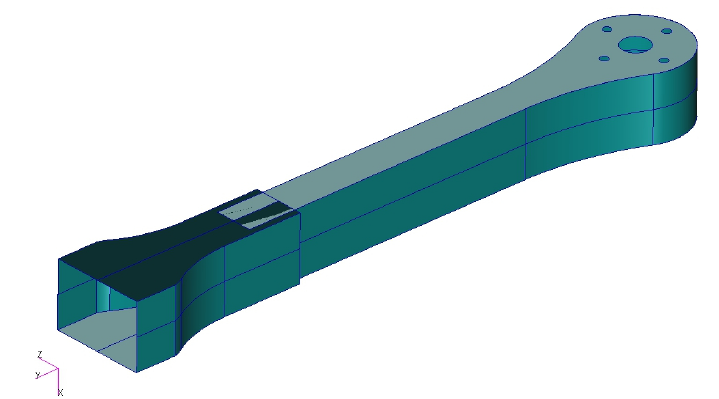
Figure 11. FE model, model setup: surrogate shell representation of the arm assembly for FE